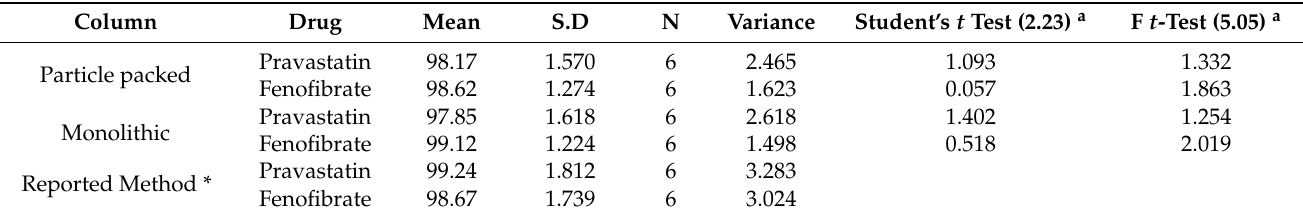
Table 6. Statistical comparison for the results obtained by the proposed method and the reported method for the analysis of the analytes in bulk powder.